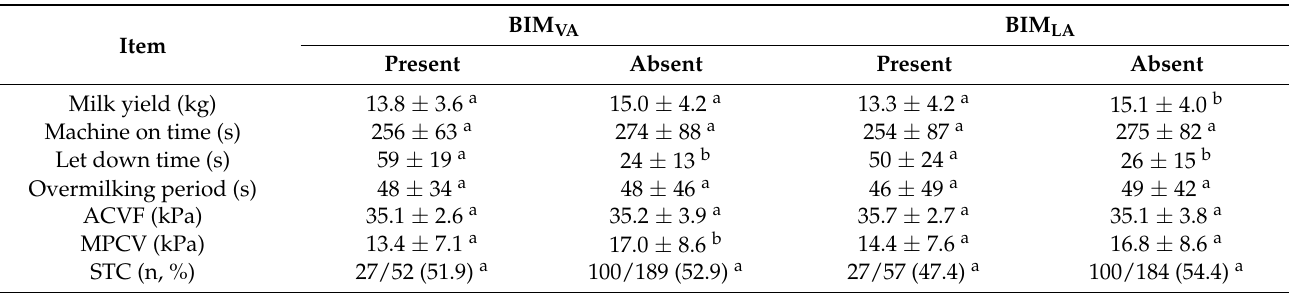
Table 4 summarizes mean values ( ± SD) of LDT stratified by the presence of bimodal- ity as assessed with the VaDia vacuum recorder (BIM VA ) and the Lactocorder (BIM LA ), respectively. The generalized linear mixed model revealed an association between LDT and BIM LA ( p < 0.0001). Controlling for the effects of parity ( p = 0.03) and stage of lactation ( p = 0.14) the odds of BIM LA increased by 87% for every 10-s increase in LDT [odds ratio (OR), 95% CI = 1.87 (1.56–2.25)]. Table 4. Descriptive statistics of milk yield, machine on time, let down time, overmilking period, average cyclic vacuum fluctuations (ACVF), average mouthpiece chamber vacuum (MPCV), and machine milking-induced short-term changes to the teat tissue condition (STC) of 241 individual cow milking observations stratified by the presence of bimodality as assessed with the VaDia vacuum recorder (BIM VA ) and the Lactocorder (BIM LA ), respectively. Values presented as mean and standard deviation unless otherwise